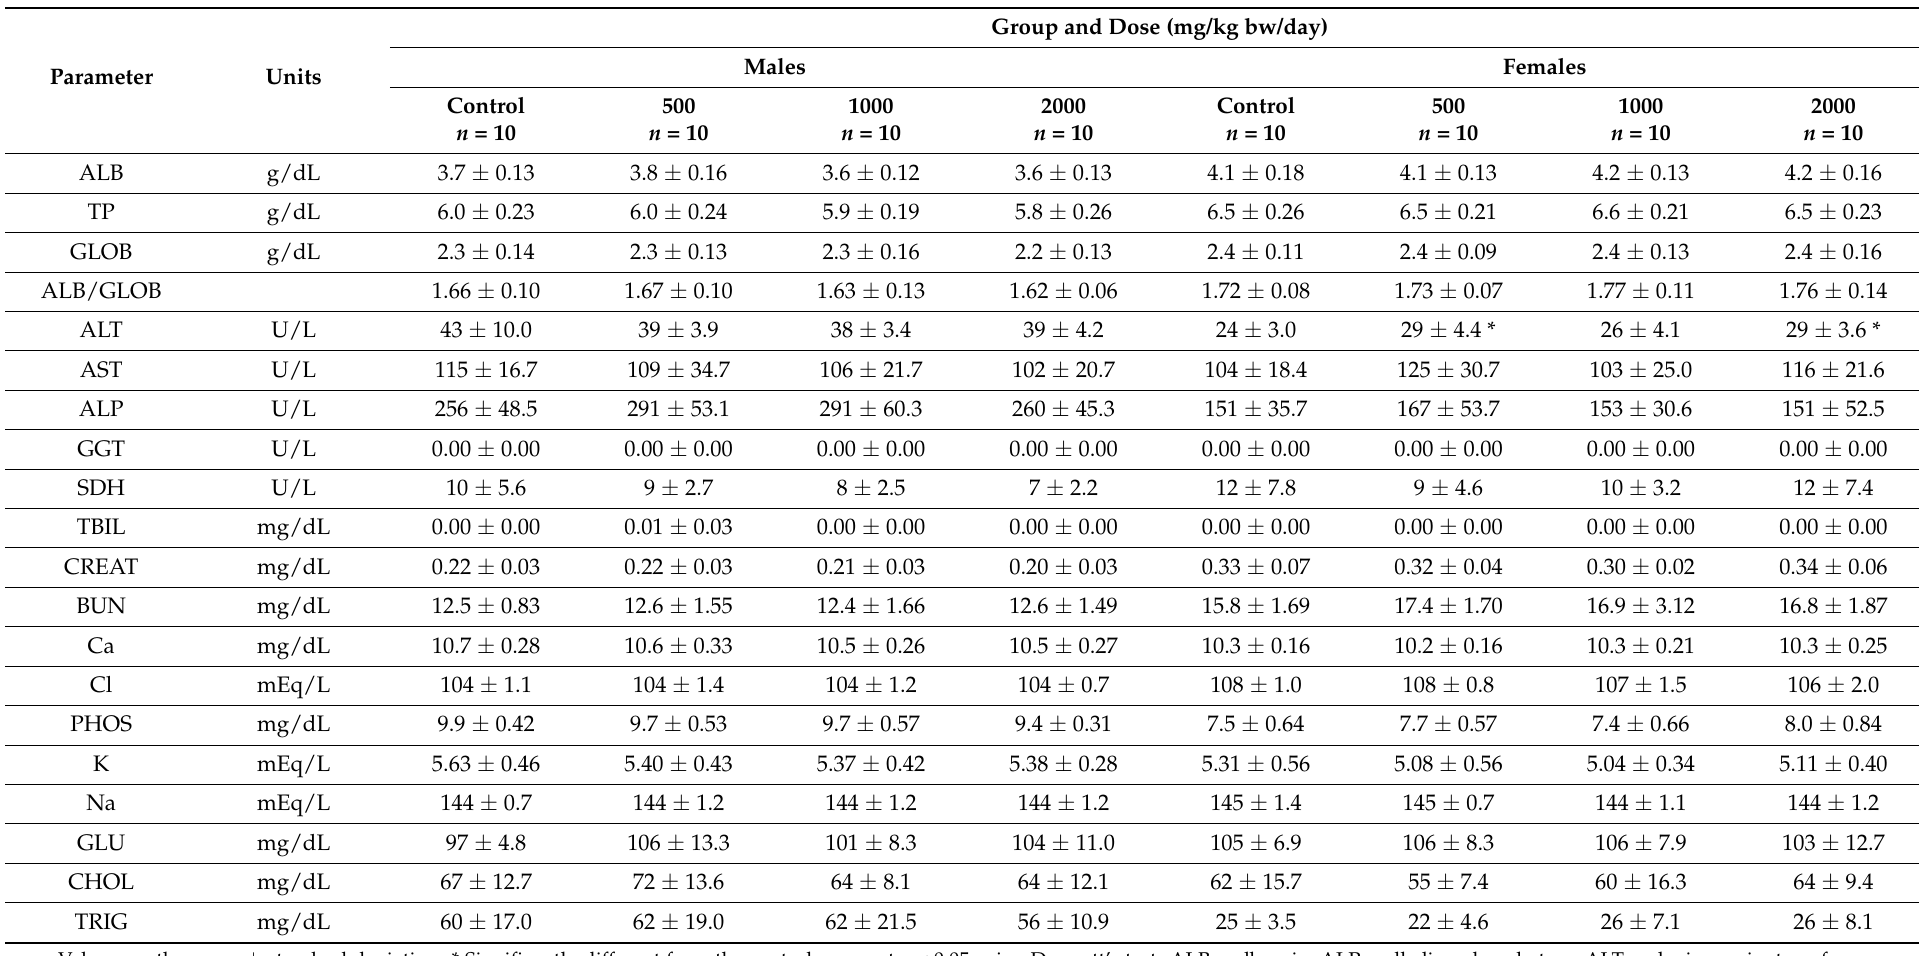
Table 4. Effect of 14 day oral administration of B. subtilis MB40 on clinical chemistry parameters in male and female